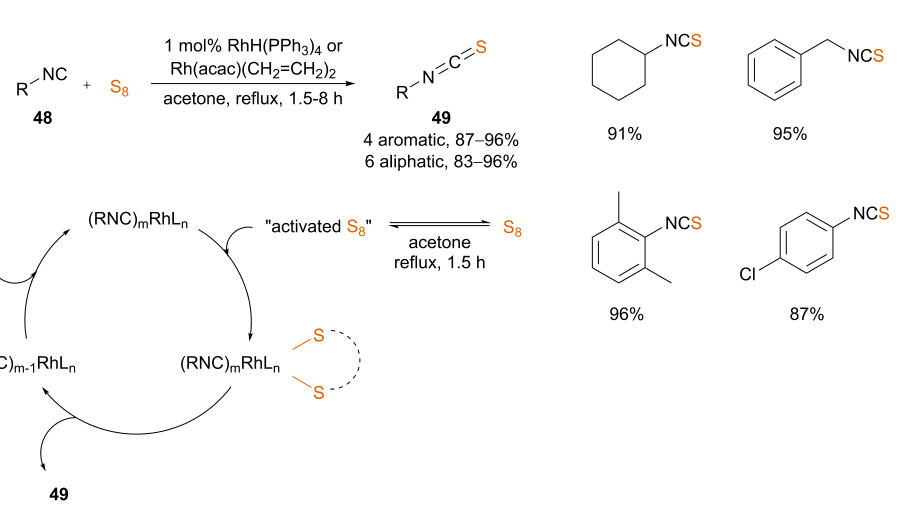
Scheme 10. Rhodium-catalyzed transformation of isocyanides ( 48 ) to ITCs ( 49 ) with selected examples and mechanistic insights ([71]). Scheme is based on Scheme 1 from